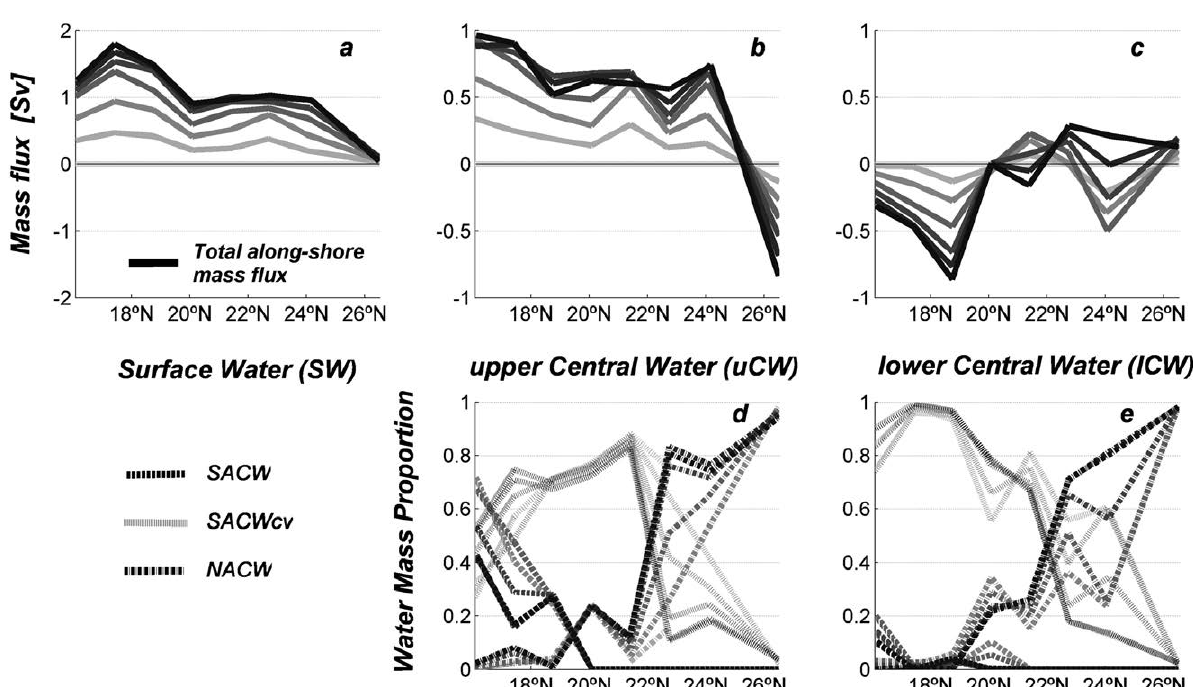
F ig . 7. – Top panels: Latitudinal change in meridional mass transport (positive northward [Sv]) for three different layers. The transports are calculated through the eight cross-shore sections, with the accumulated transports every 10 km (increasing seawards from the shelf break) represented by curves of increased darkness. Bottom panels: Average SACW, SACWcv and NACW fractions in each cross-shore section interpolated every 10 km; the increased darkness again represents the increasing seaward distance from the shelf break. Note that no OMP solution is available for SW; also note the different vertical scale for the left panel.